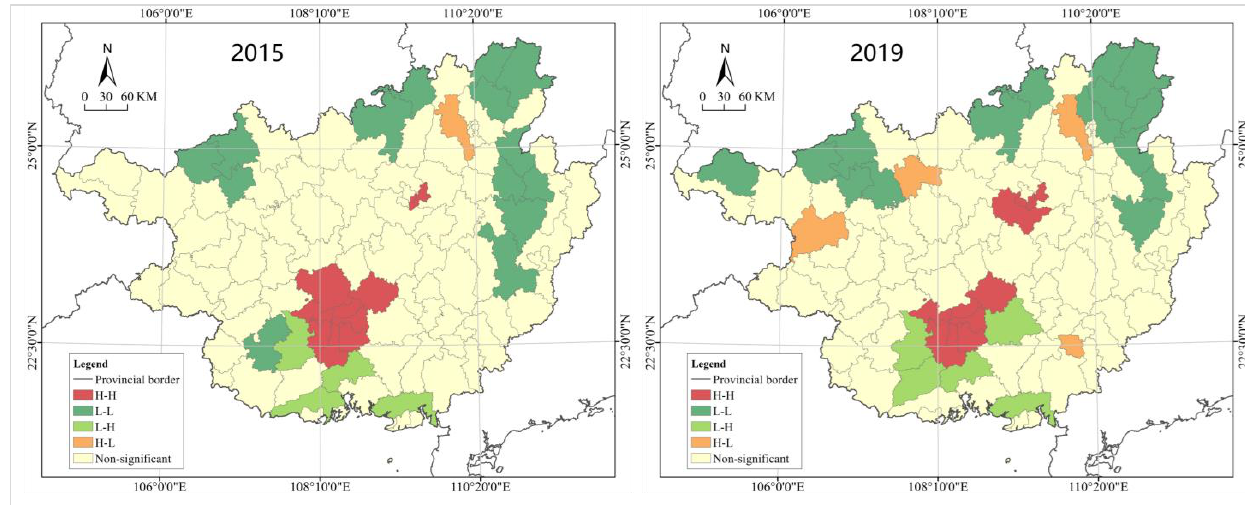
Figure 3. Spatial cluster analysis of urban night lighting index in Guangxi.